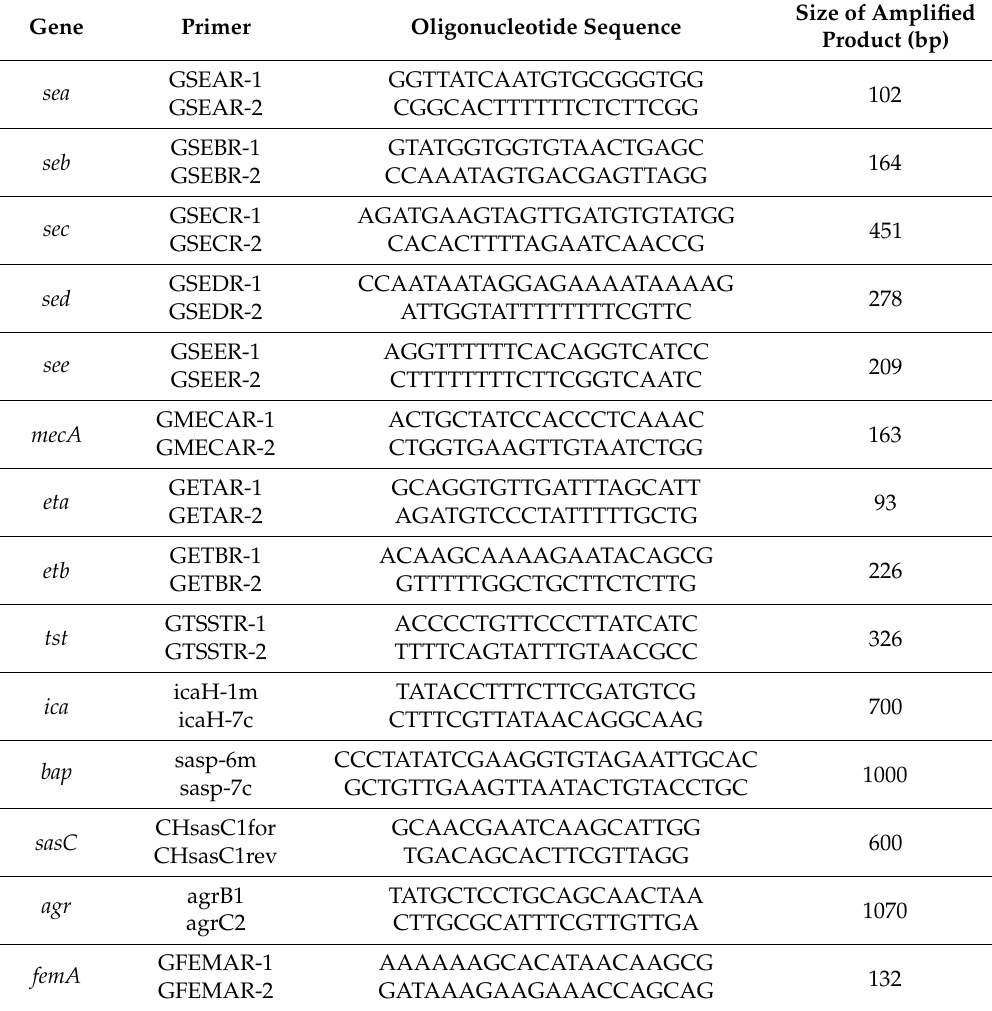
Table 6. Nucleotide sequences of primers used in this study. The PCR product size is